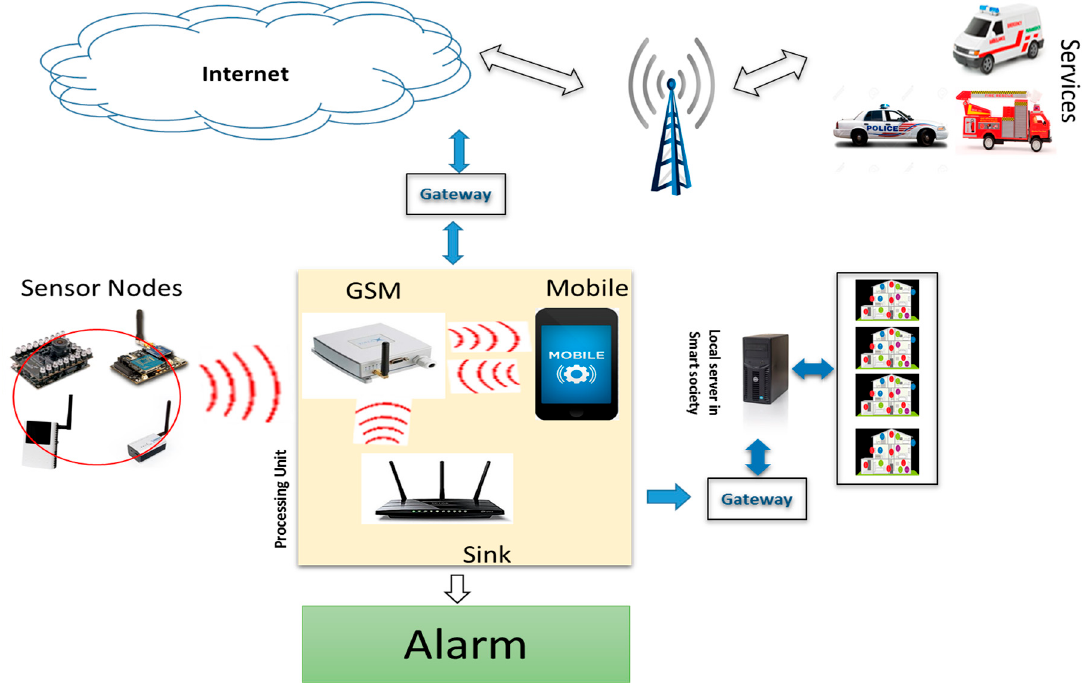
Figure 5. Skeleton of IoT-based intelligent modeling of smart home for fire prevention.